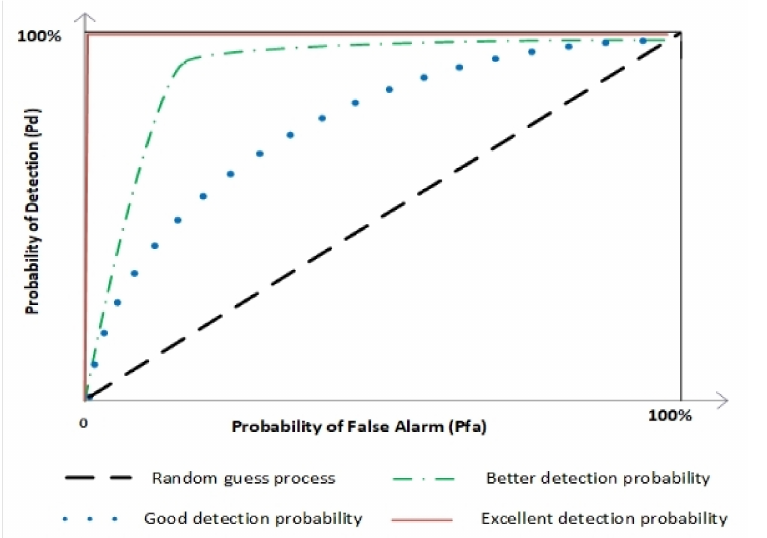
Figure 2. The ROC curve indicating the interdependence among the detection and false alarm